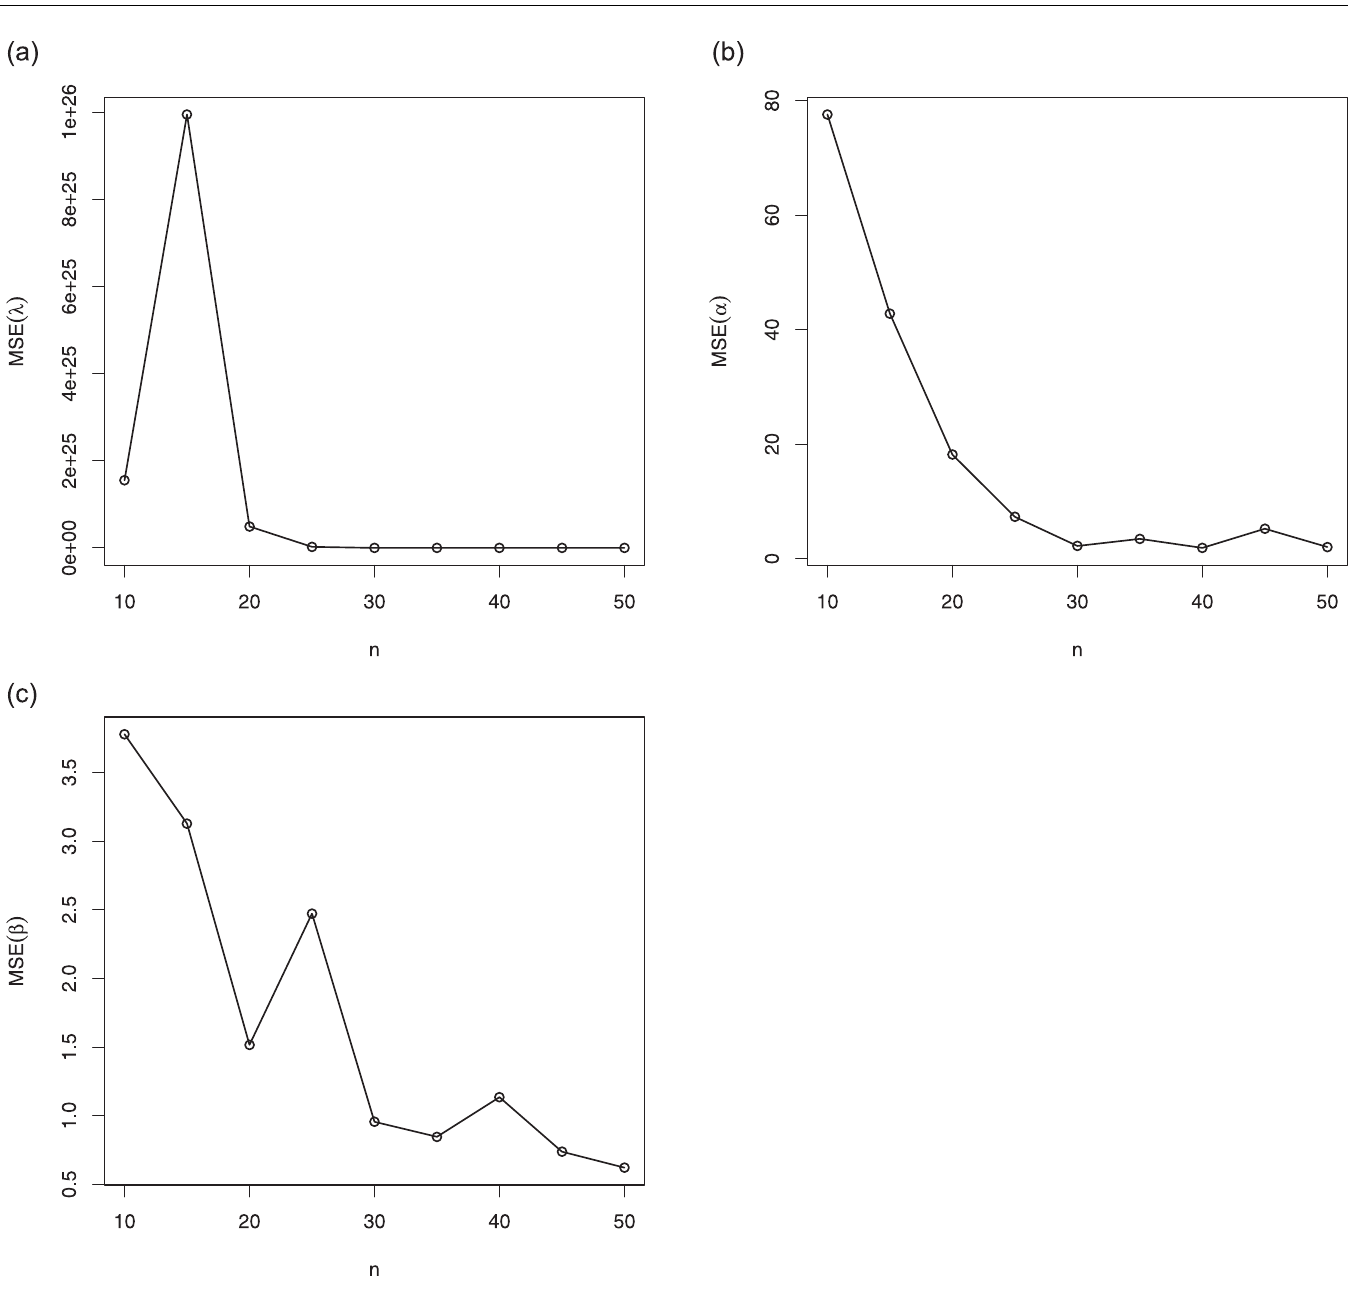
Fig 5. Plots of the empirical MSEs of the TSW model parameters for S